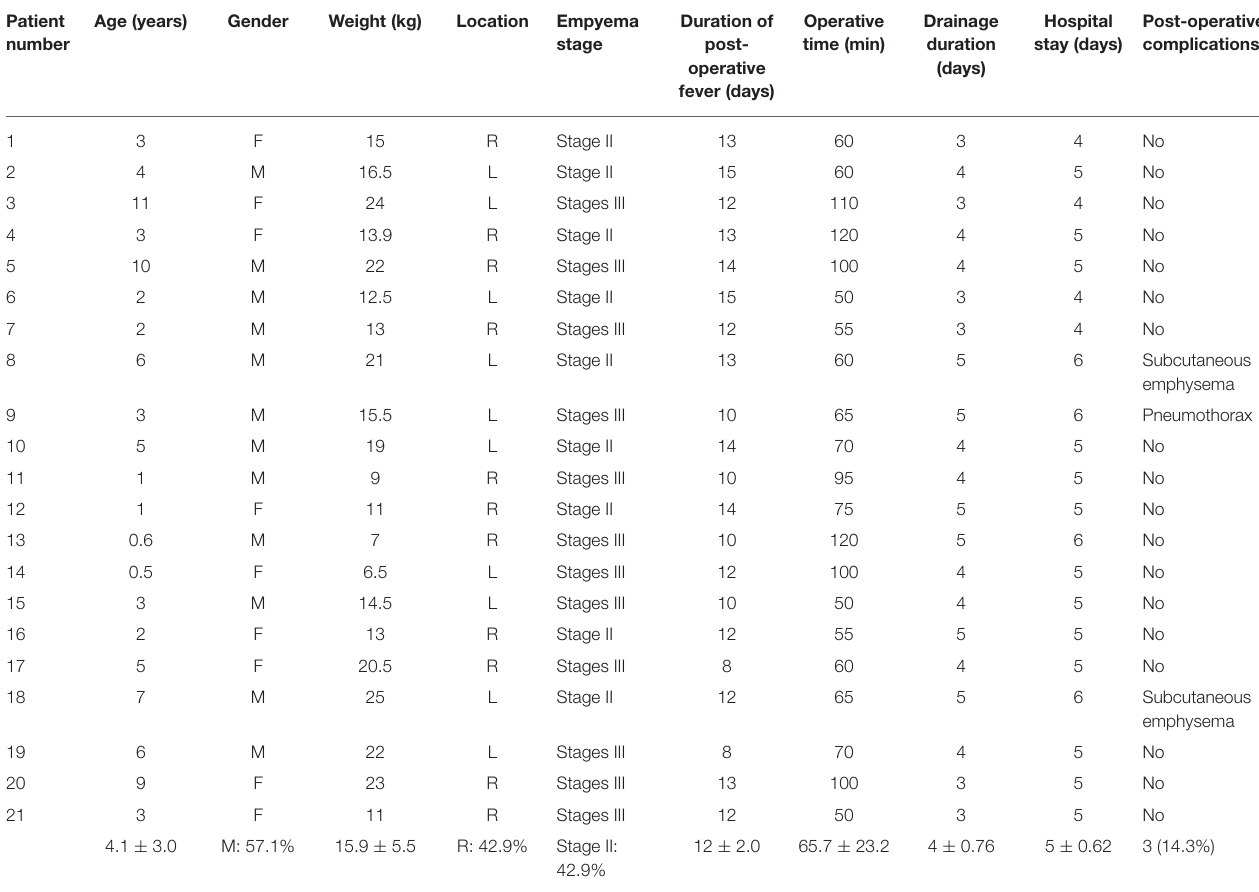
TABLE 1 | Demographical and clinical characteristics of the patients. Patient Age (years) Gender Weight (kg) Location Empyema number